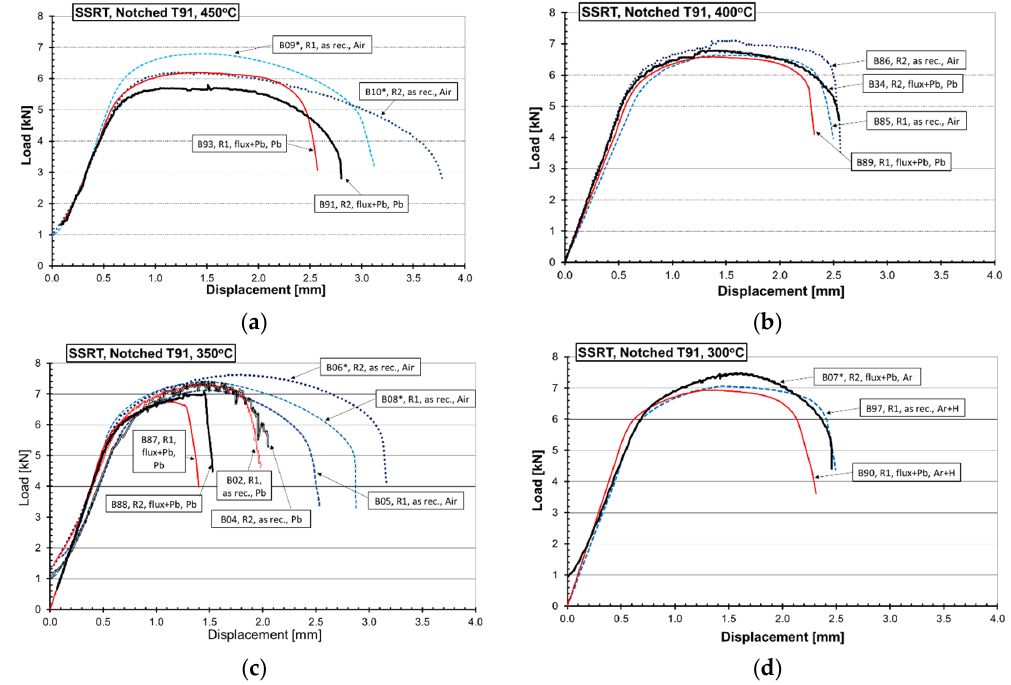
Figure 3. Load ‐ displacement curves of notched specimens tested at ( a ) 450 °C, ( b ) 400 °C, ( c ) 350 °C, and ( d ) 300 °C in air or Ar + 6% H 2 and in liquid Pb applying test rates R1 (2 × 10 − 6 m/s) and R2 (2 × 10 − 8 m/s). Surface of specimens was as received (as rec.) or treated by flux and lead (flux + Pb). The star next to the specimen name means shorter notch depth, 0.15 mm, which consequently caused higher load. Table 5. Test results: Fgy and Fmax are loads at general yielding and maximum; f_max and f_final are displacements at maximum load and rupture. LME max is the maximum cleavage ‐ like crack depth at rupture from SEM observations.